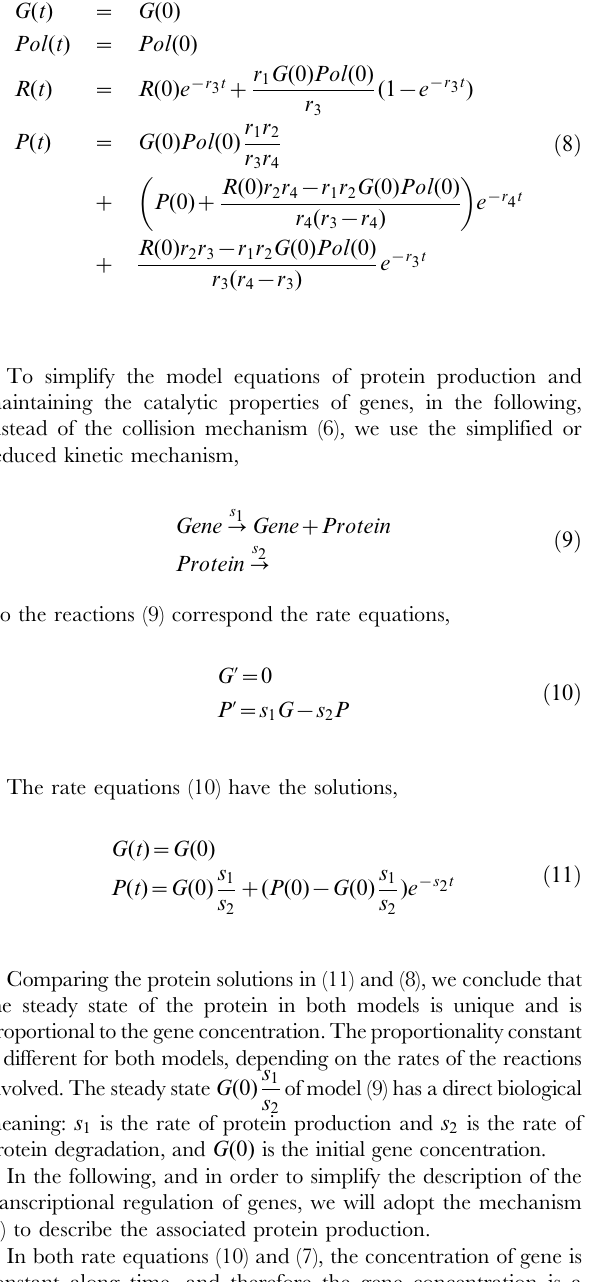
GeneticNetworks software package, bcd, hb, BCD, HB, KNI and TLL are the names of the vertices of the regulation graphs, but the operon variables in (12) are generated by the software.